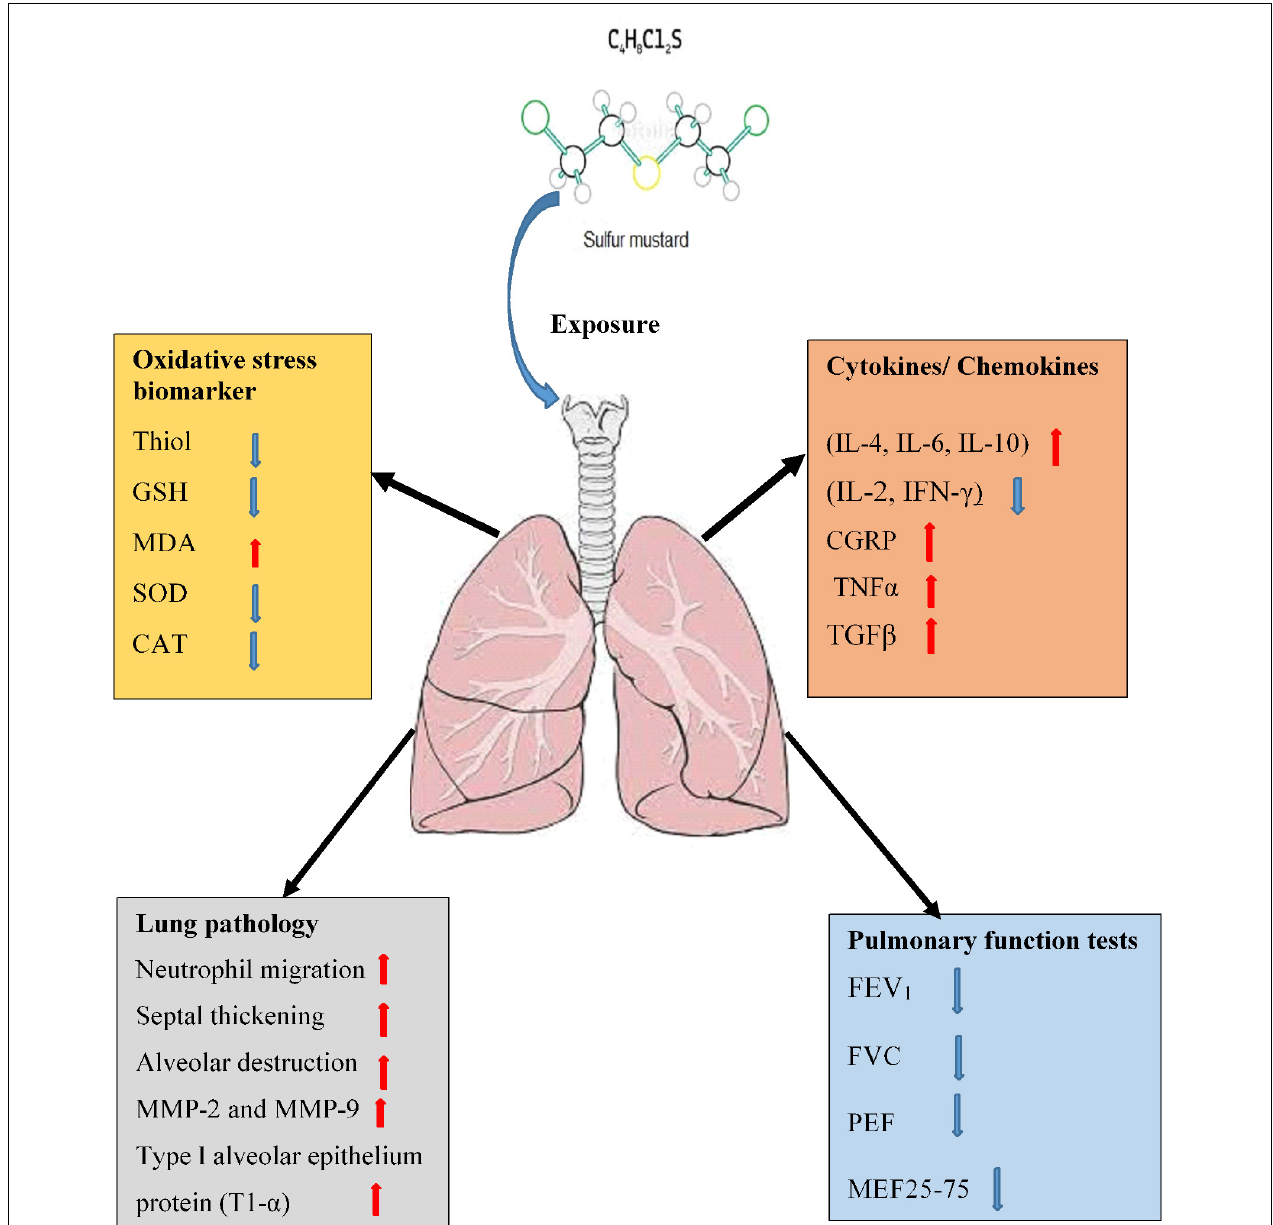
FIGURE 1 | Possible mechanisms of lung injury induced by SM exposure. MDA, malondialdehyde; GSH, glutathione; SOD, superoxide dismutase; CAT, catalase; TGF- β 1, transforming growth factor-beta1; IL, interleukin; IFN γ , interferon gamma; TNF α , tumor necrosis factor- α ; MMPs, matrix metalloproteinase; FVC, forced volume capacity; FEV1, volume in one second; PEF, peak expiratory flow; MEF, maximal expiratory